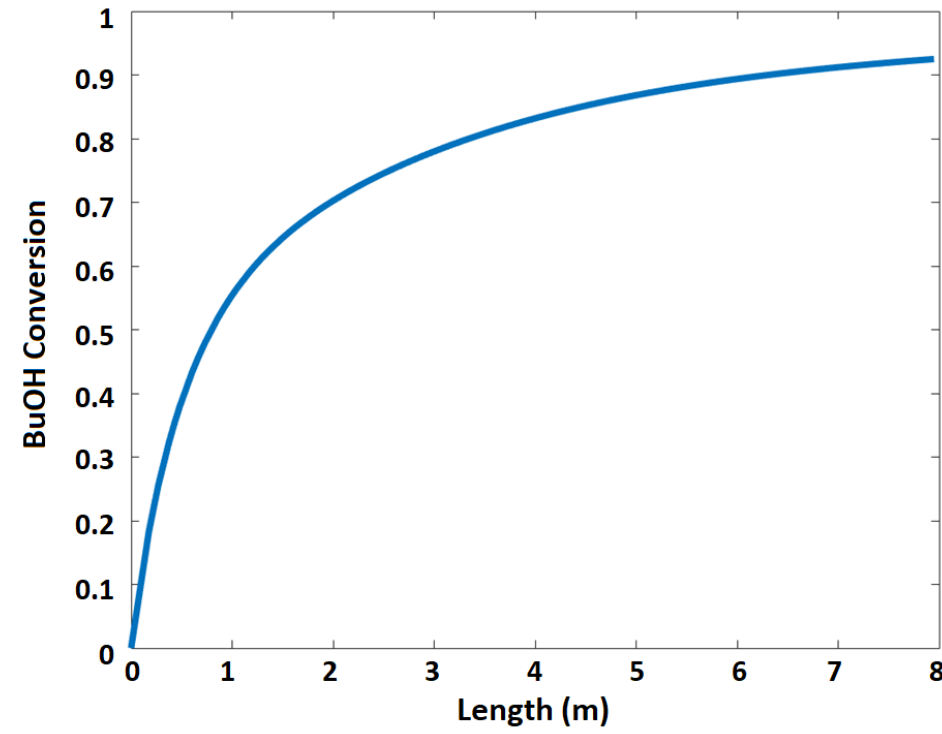
Figure 7. n -Butanol conversion as a function of the length of the membrane reactor.